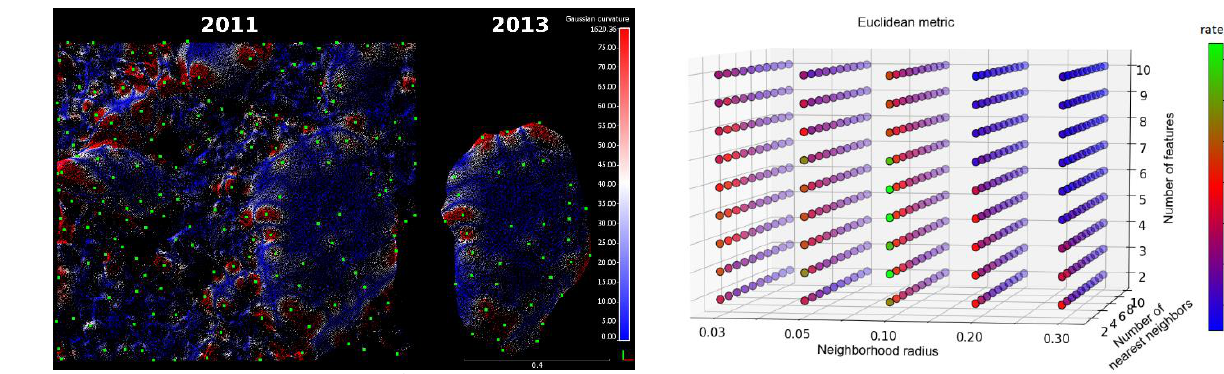
Figure 4. Key point detection results for the neighborhood size Figure 6. Results of the experiments for Euclidean metric of 3 cm. Blue, white, red – Gaussian curvature, green – key points